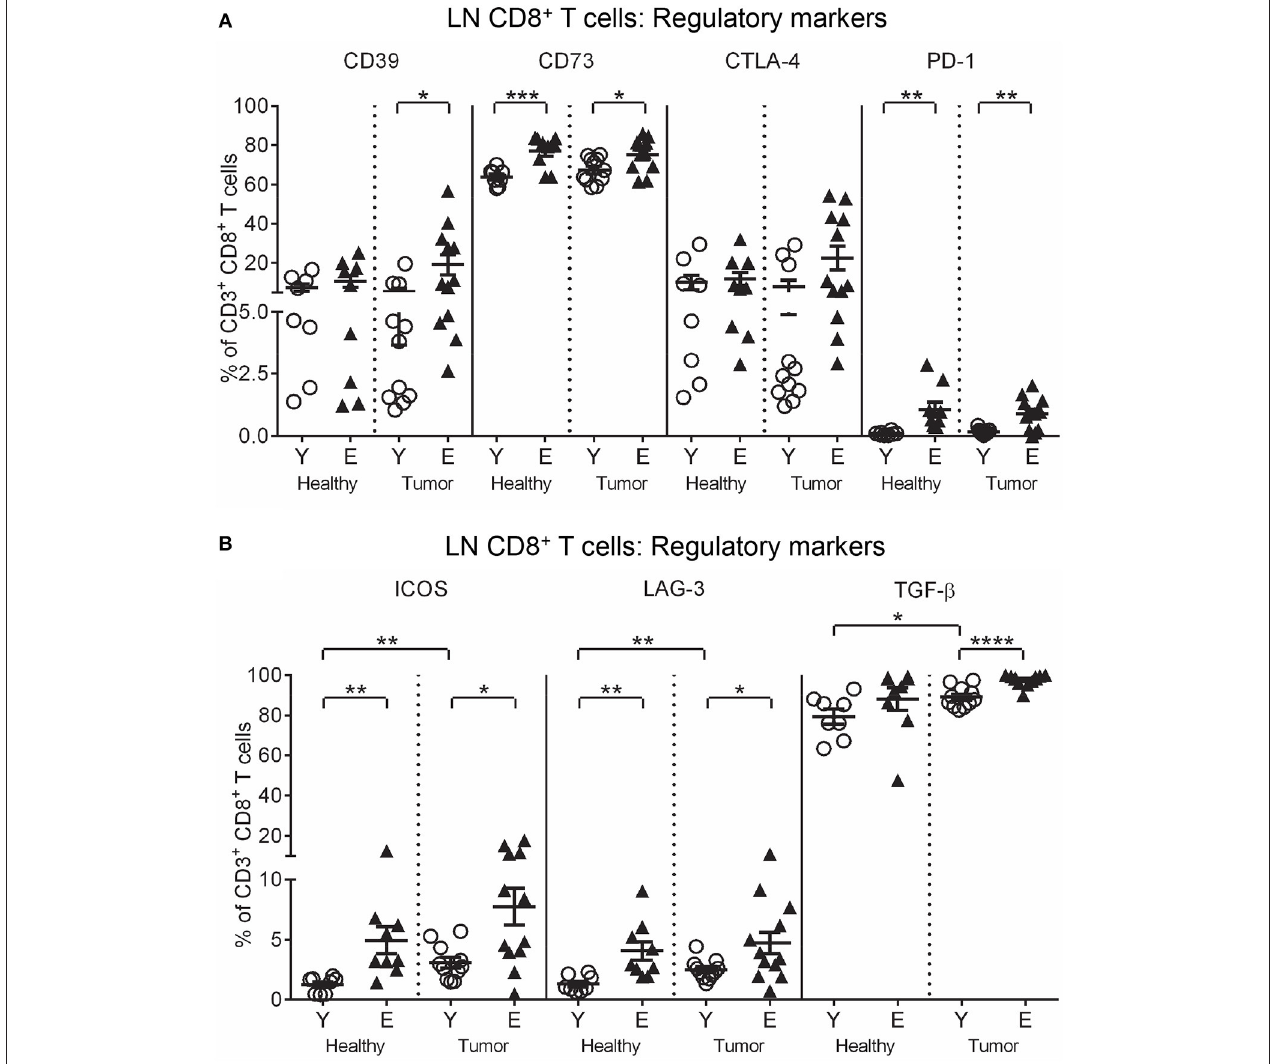
FIGURE 3 | Increased regulatory markers on elderly LN/TDLN CD8 + T cells. Percentages of CD8 + T cells positive for regulatory markers were measured in TDLNs from young and elderly tumor-bearing mice, and LNs from age-matched healthy young and elderly mice, as per Figures 1 , 2 ( A , B ), via flow cytometry. Data are shown for individual mice as well as mean ± SEM, n = 11 young and n = 12 elderly tumor-bearing mice, n = 8 young and n = 9 elderly healthy mice, * p < 0.05, ** p < 0.005, *** p < 0.0005, **** p < 0.0001 comparing (i) young to elderly mice, or (ii) tumor-bearing mice to age-matched healthy mice.